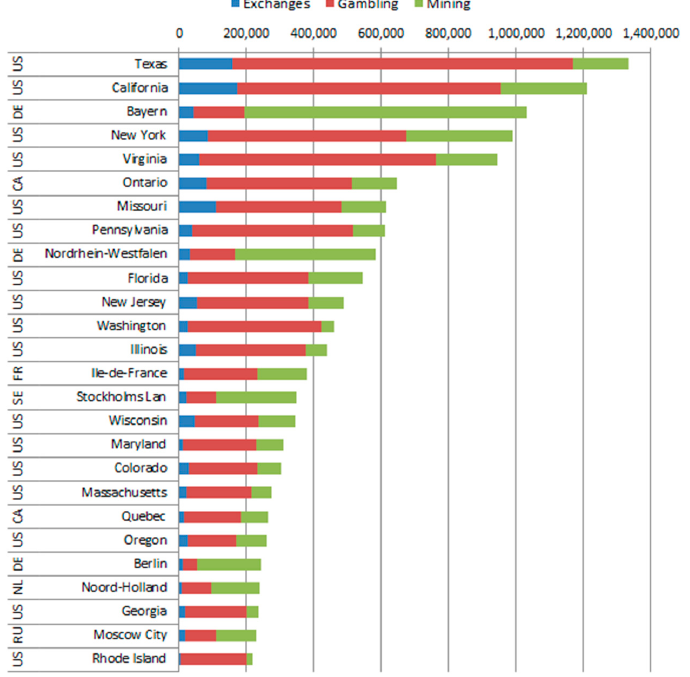
Figure 20. Transaction Volume in BTC and Business Distribution for Top 30 Regions.